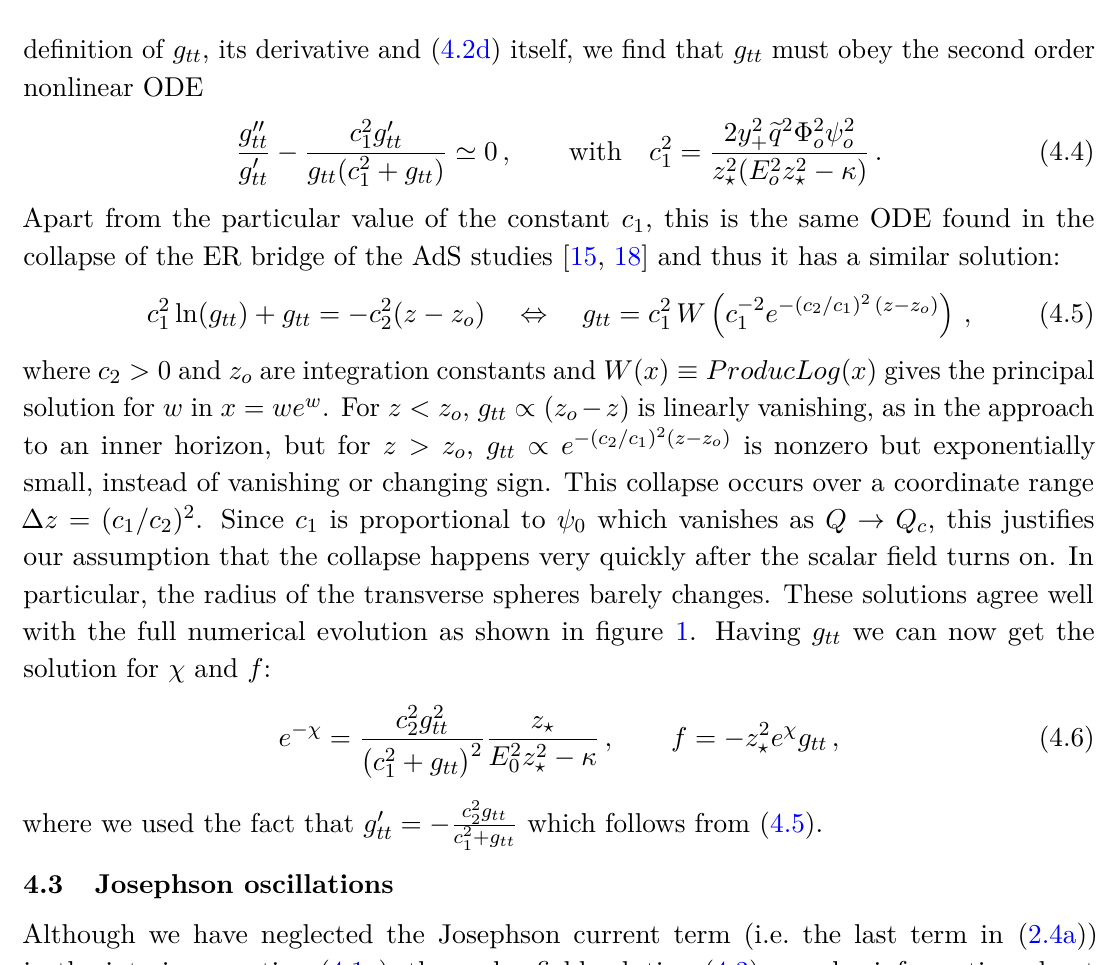
Figure 1 . A comparison of the numerical solutions (solid grey lines) and fits to the analytic expressions (4.3) and (4.5) (black dotted curves) describing the collapse of the Einstein-Rosen bridge. This is for mM = 0 . 941632 , Q/Q c = 1 . 001833 , q = m and α = 1